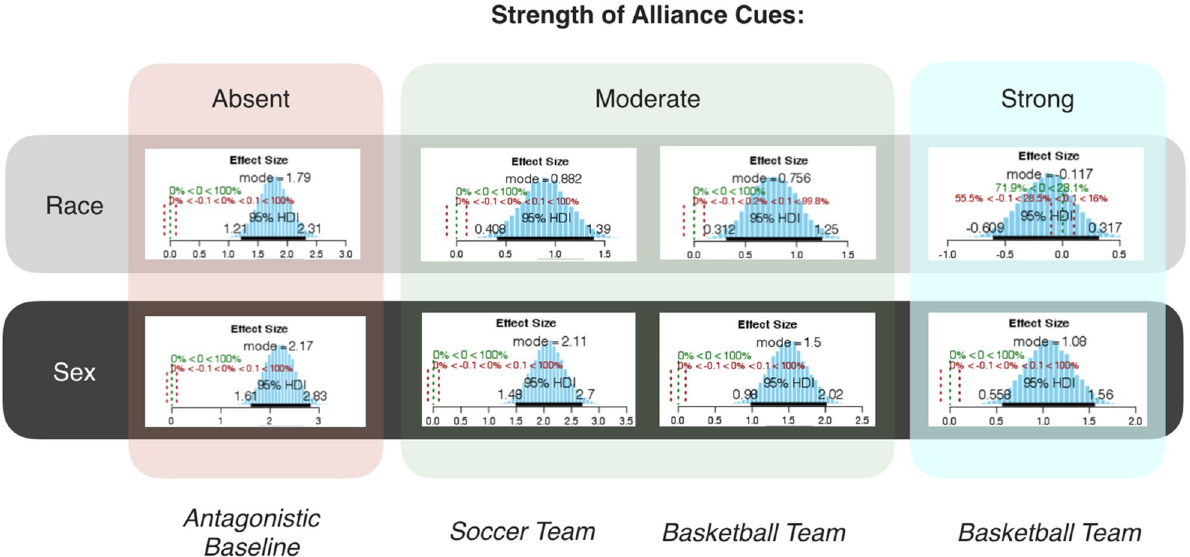
Figure 4. Posterior distributions of categorization effect sizes, using Bayesian estimates of differences in